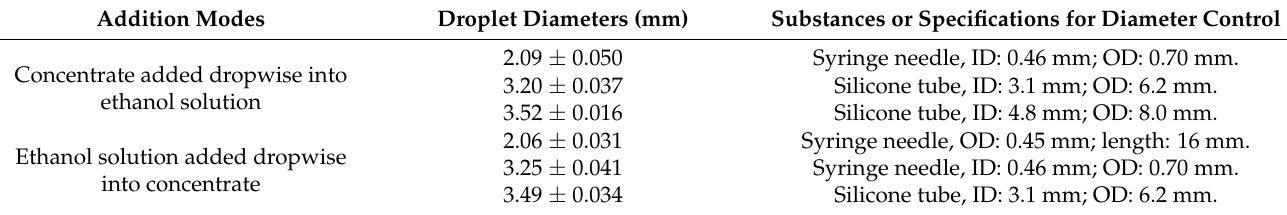
Figure 3. Schematic diagram for adding ethanol solution dropwise into the concentrate under stirring. When adding concentrate dropwise into ethanol solution, the position of ethanol solution and concentrate was exchanged. Table 1. Conditions for single-factor experiments on stirring devices.